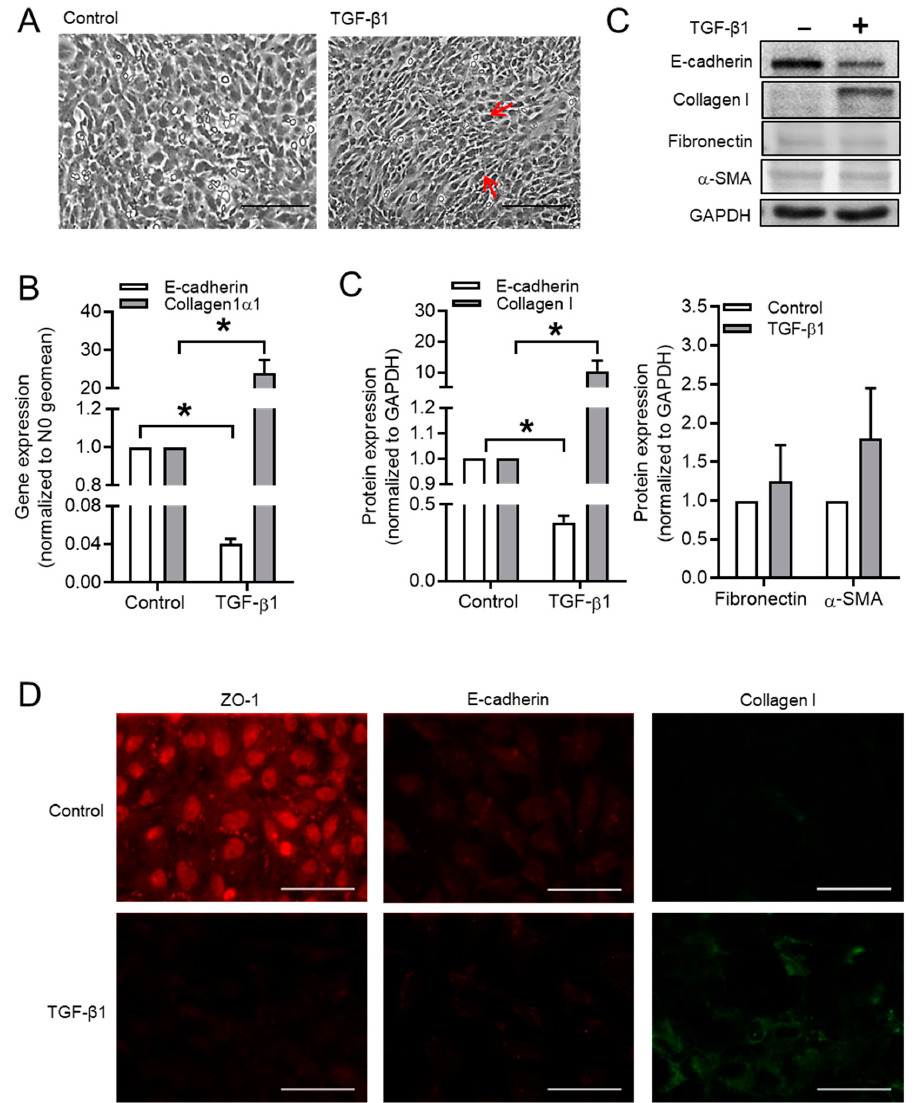
Figure 1. Effects of transforming growth factor- β 1 (TGF- β 1) on cell morphology and epithelial-to- mesenchymal transition (EMT) markers. ( A ) Morphological changes of BEAS-2B cells after stimulated with TGF- β 1 (3 ng/mL) for 24 h. Spindle-like cells were indicated with red arrow. ( B , C ) Gene ( B ) and protein ( C ) expressions of E-cadherin, collagen Ӏ , fibronectin and α -smooth muscle actin ( α -SMA) were analyzed in BEAS-2B cells with or without TGF- β 1 stimulation using real-time quantitative PCR and western blotting, respectively. Representative western blotting images of E-cadherin, collagen Ӏ , fibronectin and α -SMA were shown in ( C ). ( D ) Immunofluorescence images of ZO-1, E-cadherin, and collagen Ӏ after 24 h stimulation of TGF- β 1. Scale bar represents 100 μ m. Data represent 3–6 independent experiments. Data are expressed as mean ± SEM, * p < 0.05; significant difference between indicated groups.